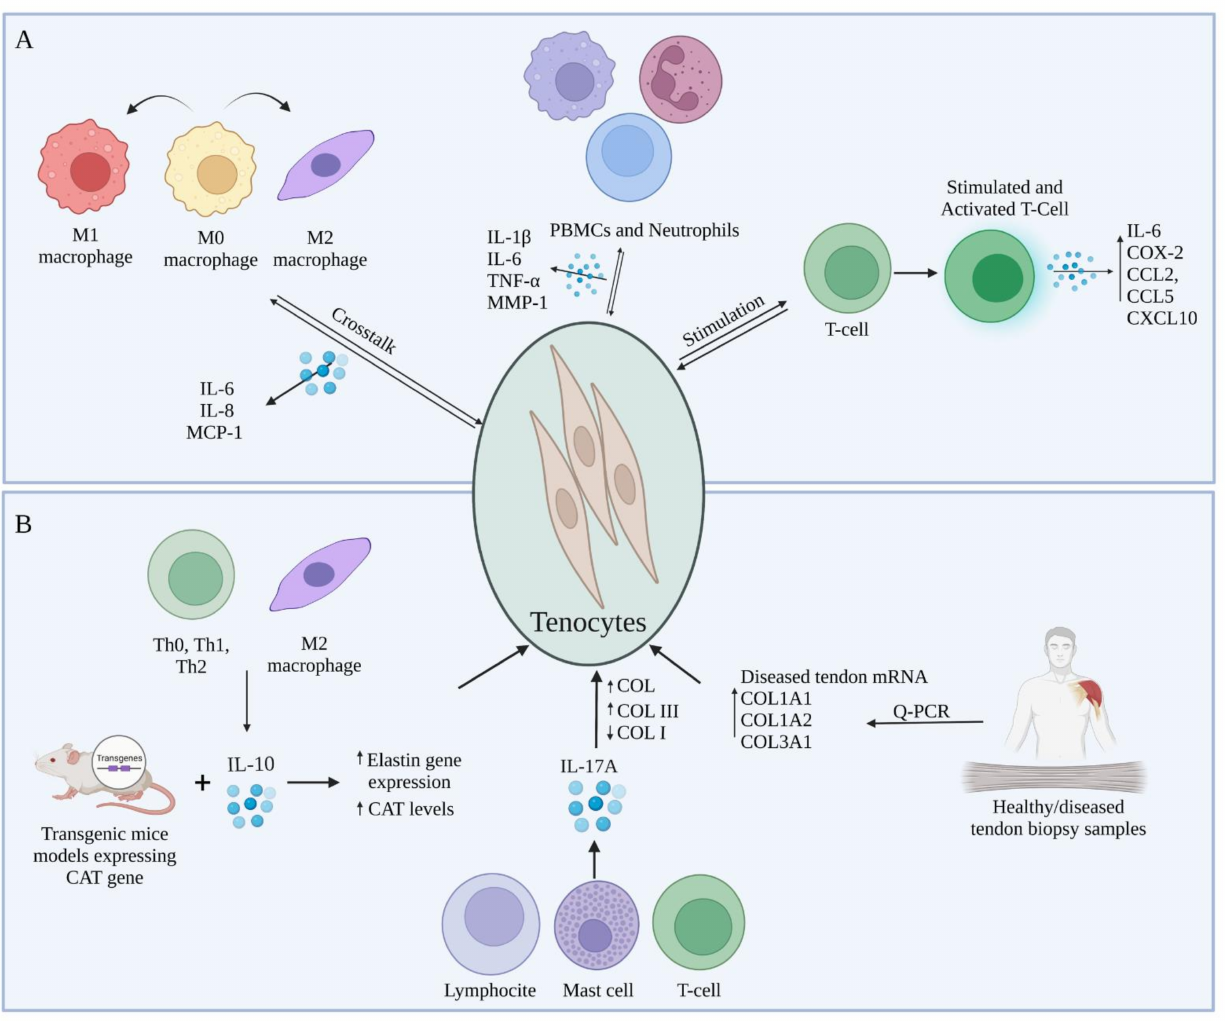
Figure 2. Representation of the prevalent immunomodulatory crosstalk between tenocytes and immune cells during tendon healing tested ( A ) in vitro and ( B ) in